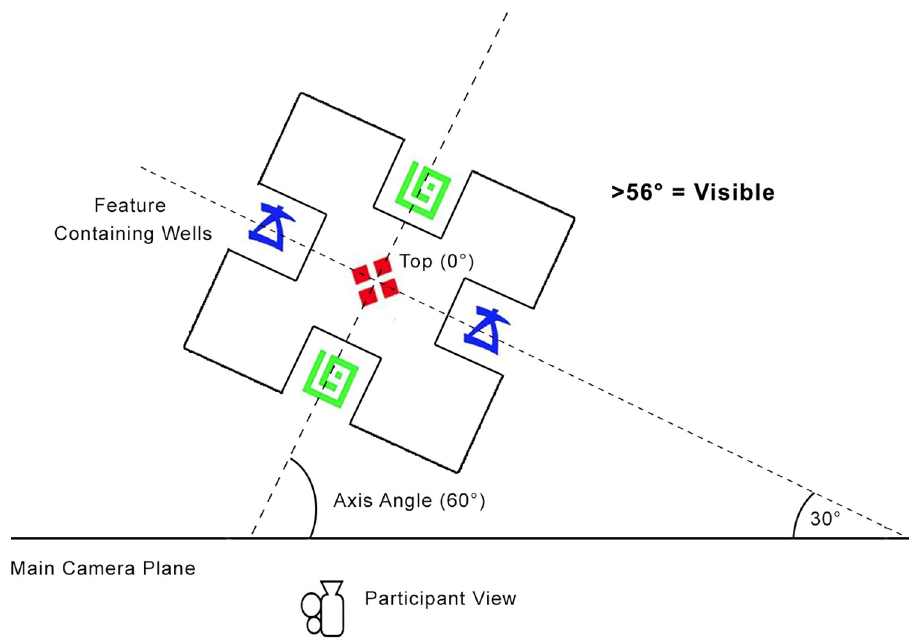
Fig 5. The axis angle is calculated to reveal which feature is in view. The participant rotates the cube about a central point. As the cube is rotated relative to the position of the participant view, features are exposed inside the wells. As the cube is rotated, the axis angle changes. This can be used to determine when a feature is visible to the viewer. At 56 degrees of rotation, the feature begins to be viewable to the